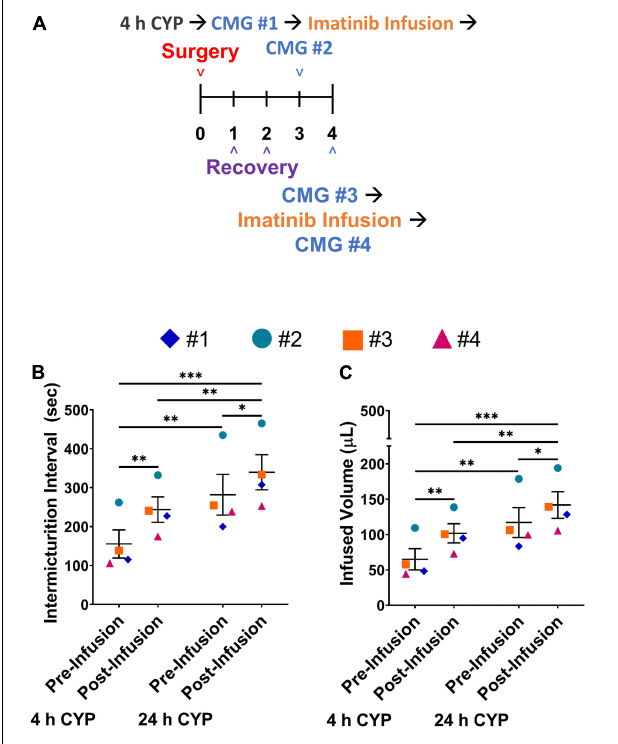
FIGURE 7 | Two intravesical infusions with imatinib mesylate significantly increases IMI and IV in female mice with acute (4 h) CYP-induced cystitis. (A) Acute CYP-induced cystitis (200 mg/kg, 4 h, i.p.) experimental schedule for two-dose imatinib mesylate treatment via intravesical bladder infusion (50 µ M, 30 min, 0.5 mL). Acute cystitis is induced on the third day. Bladder function with cystometrogram (CMG) is recorded 4 h after the CYP injection, before and after an intravesical bladder infusion of imatinib mesylate, and again, 24 h after the CYP injection on day 4, before and after a second imatinib mesylate intravesical bladder infusion. (B,C) Imatinib mesylate treatment significantly ( p ≤ 0.01) increased the IMI and IV in female mice with acute CYP-induced cystitis at 4 and 24 h ( p ≤ 0.001) following CYP. n = 4. Values are mean ± SEM. ∗ p ≤ 0.05; ∗∗ p ≤ 0.01; ∗∗∗ p ≤ 0.001; by two-way repeated measures ANOVA with Bonferroni’s multiple comparisons test. CMG,